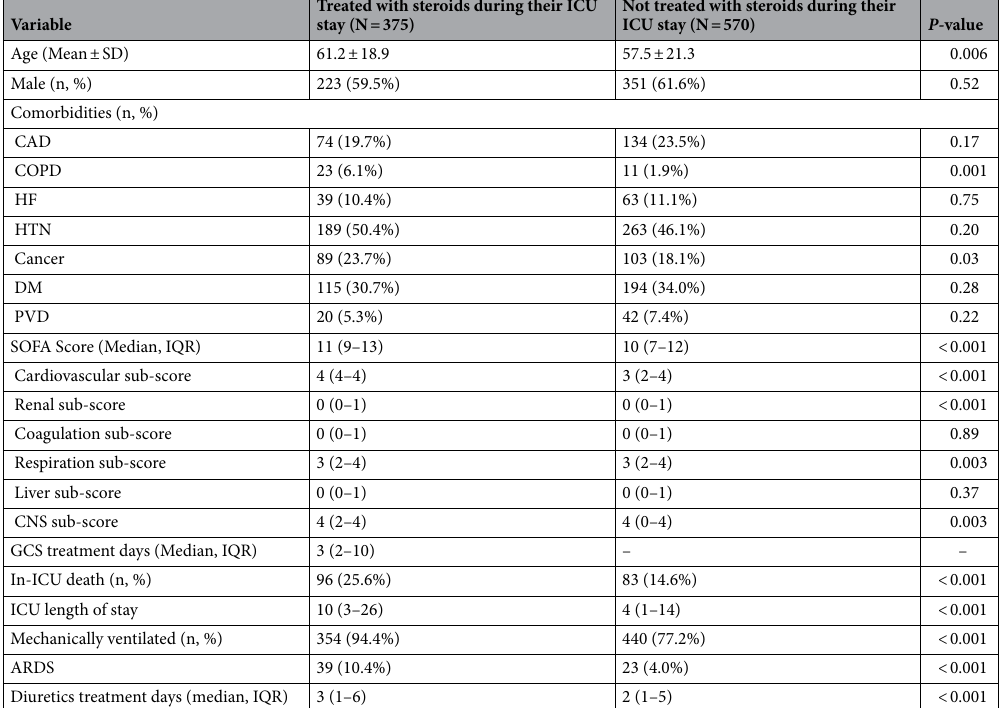
Table 1. Characteristics of patients at admission to the intensive care unit. ICU intensive care unit, CAD coronary artery disease, COPD chronic obstructive pulmonary disease, HF heart failure, HTN